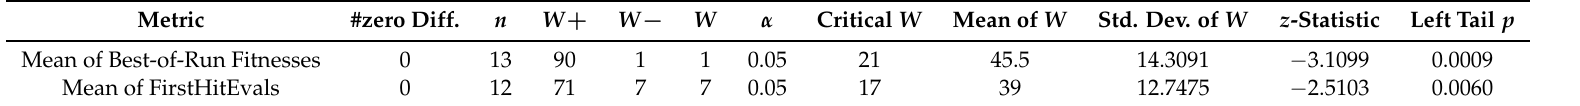
Table 11. Wilcoxon signed rank tests: Jaya vs. Sjaya on the fuel cell problem.